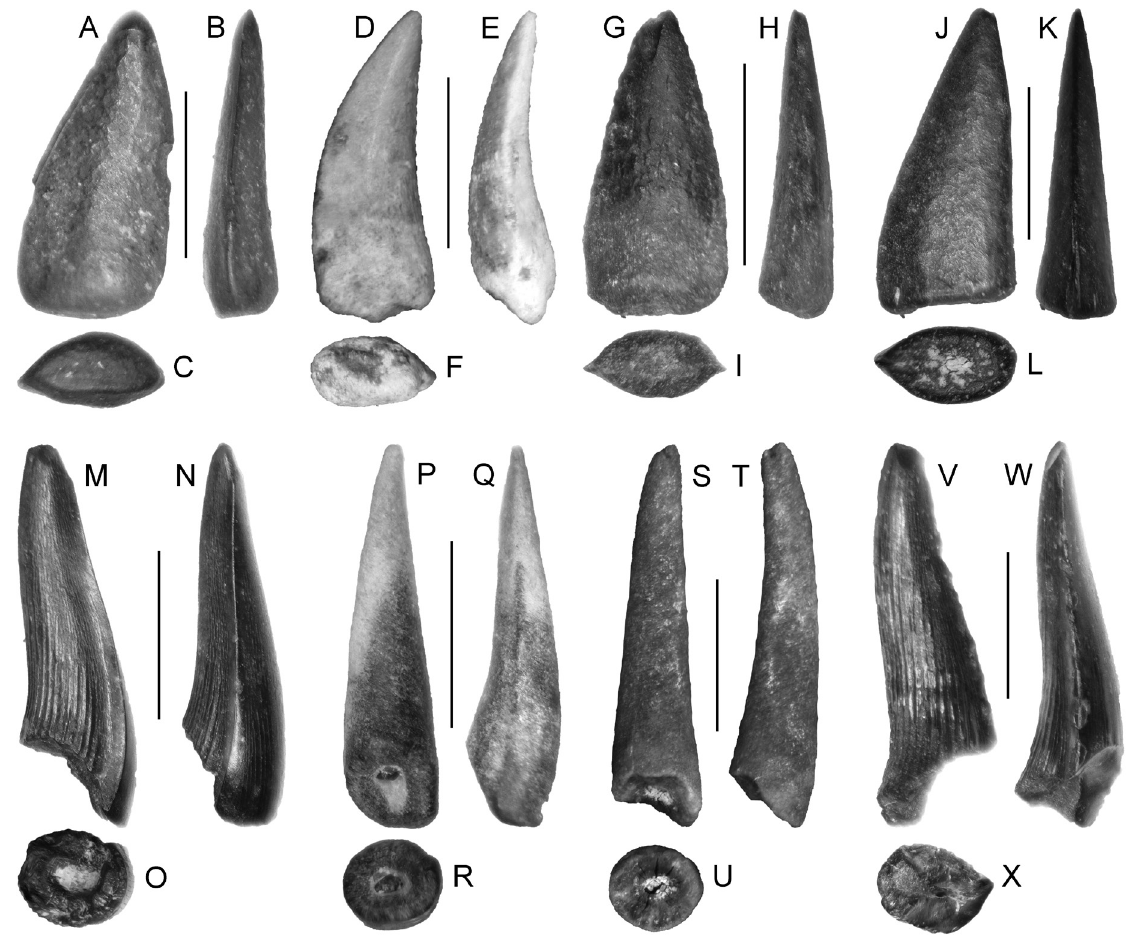
Fig. 62. Sphyraena sp. and Eutrichiurides plicidens (Arambourg, 1952) comb. nov., teeth. A–L . Sphyraena sp. A–C . MSC 37142, laniary tooth, Tallahatta/Lisbon formation contact zone, courtesy of James Lowery. A . Lingual view. B . Anterior view. C . Basal view. D–F . MSC 35779,